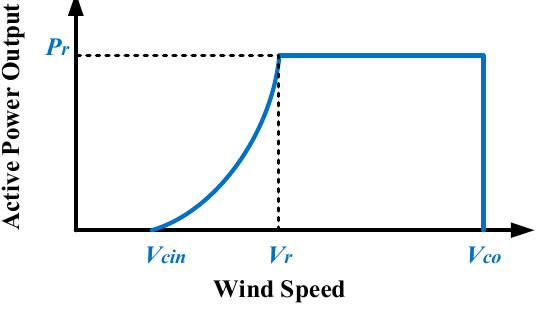
Figure 1. Speed-power curve of a wind turbine.